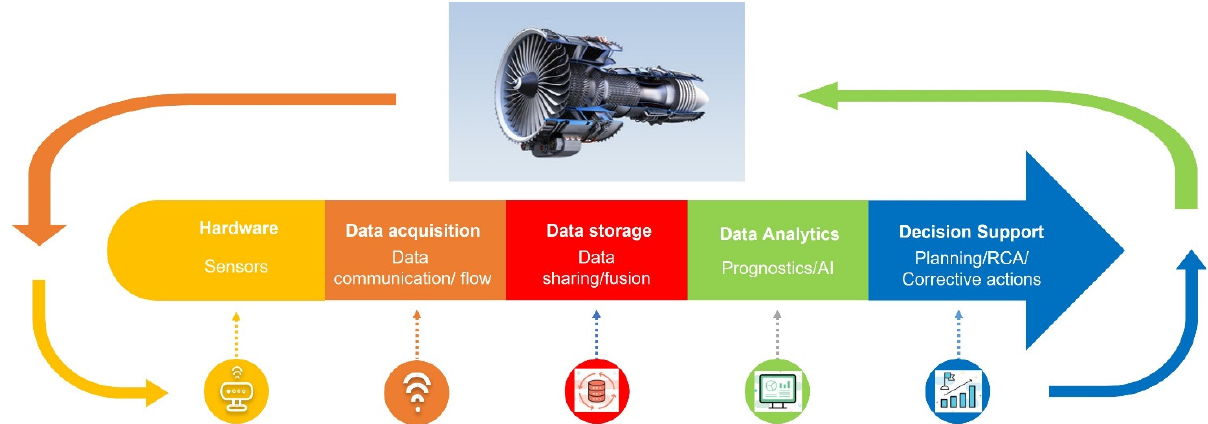
Figure 1. Overview and components of CBM approach (adjusted from [9]).